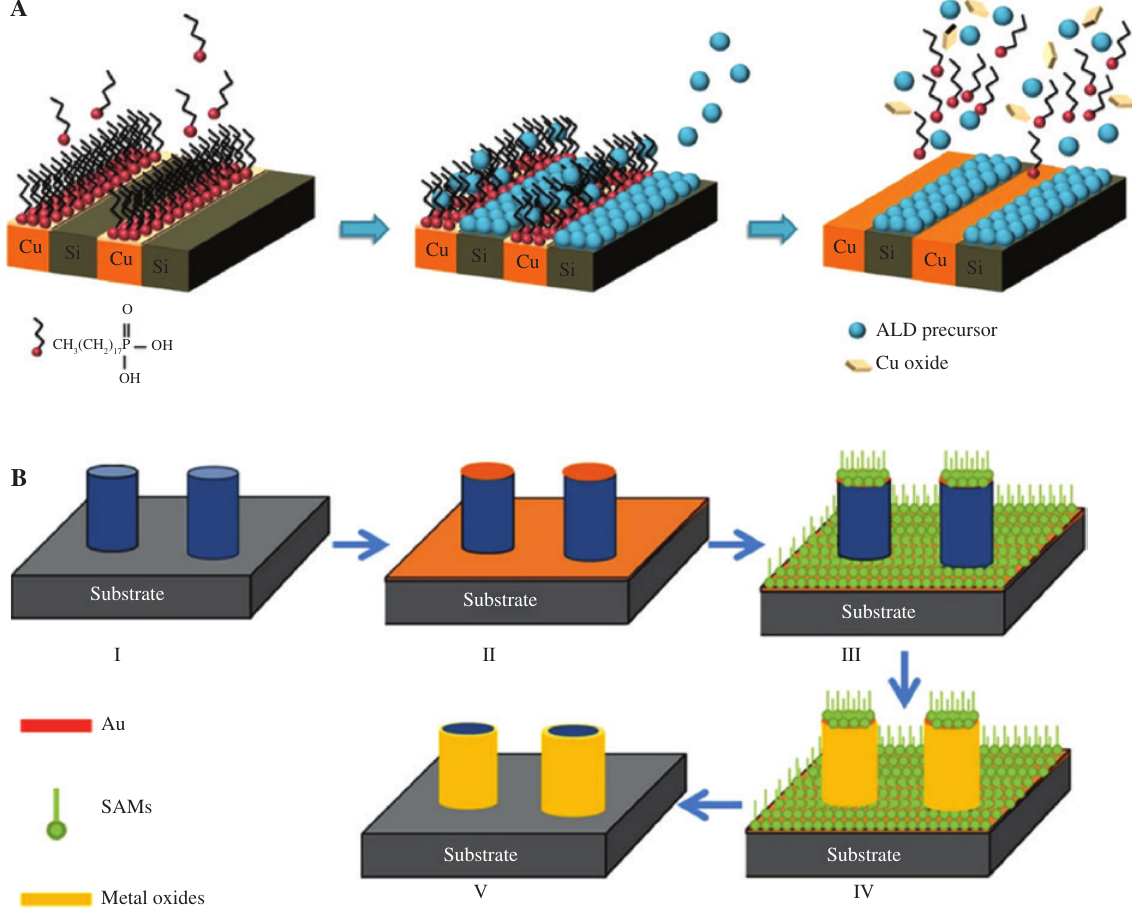
Figure 12: (A) Schematic demonstration of self-aligned patterning through a combination of selective deposition and selective removal of dielectric material. Reprinted with permission from Ref. [95]. Copyright 2015 American Chemical Society. (B) Schematic diagrams of the 3D (area-selective) ALD of a metal oxide on the vertical surfaces of standing nanopillar structures. Reprinted with permission from Ref. [97]. Copyright 2014 Nature Publishing